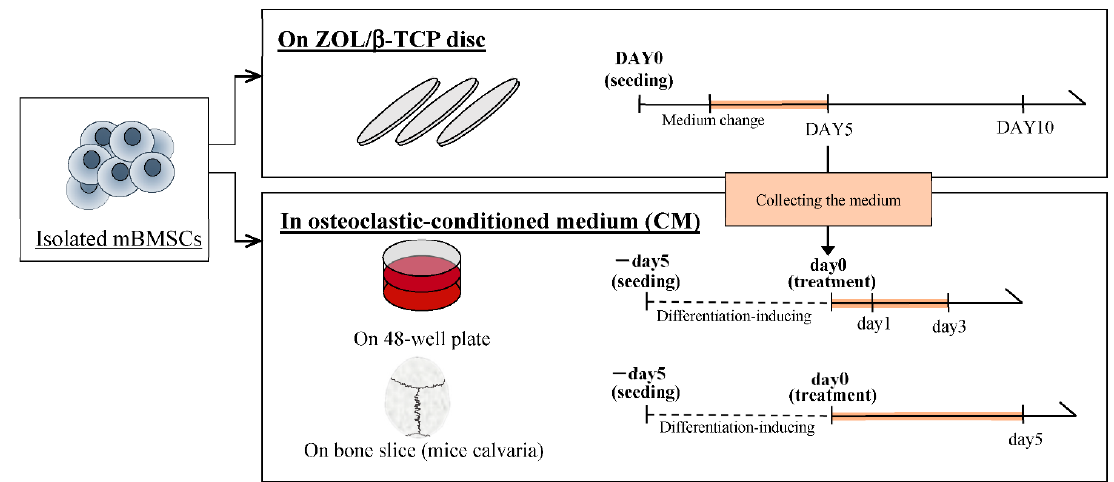
Figure 6. Schedule of examination of mBMSCs differentiation and activation.